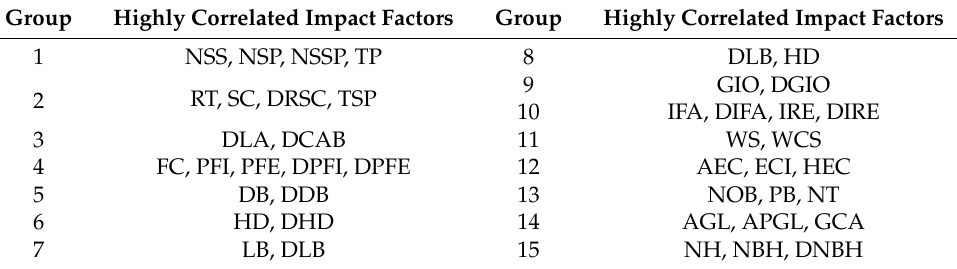
Table 1. Groups of highly correlated impact